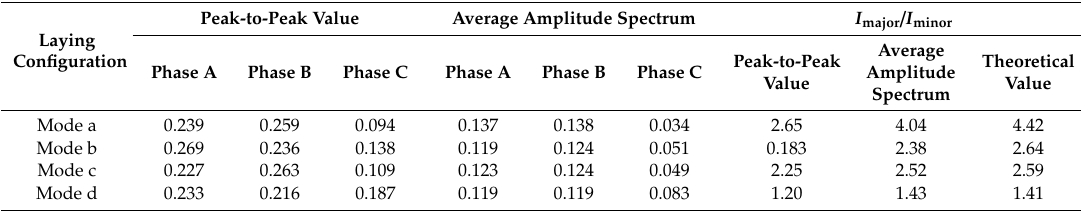
Table 3. Measured Signal Amplitudes and the Ratio of I major / I minor .